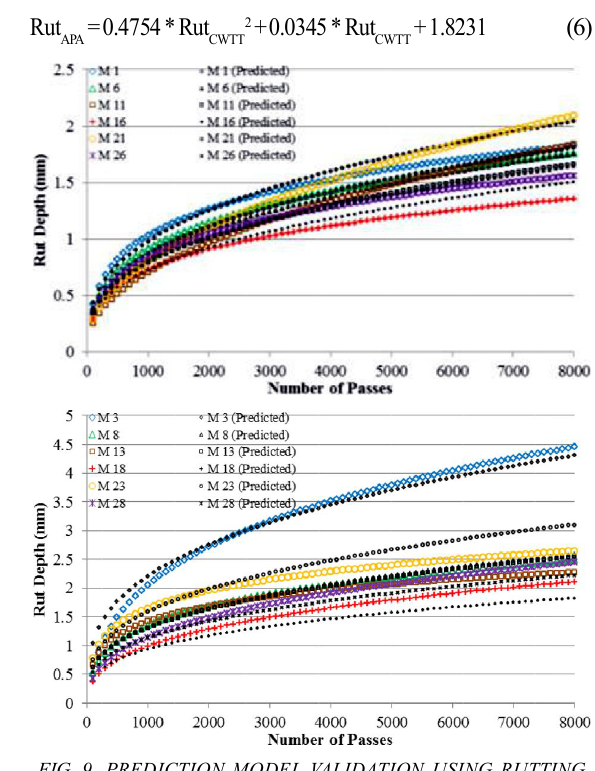
FIG. 9. PREDICTION MODEL VALIDATION USING RUTTING DEVELOPMENT CURVES OF REPRESENTATIVE MIXTURES